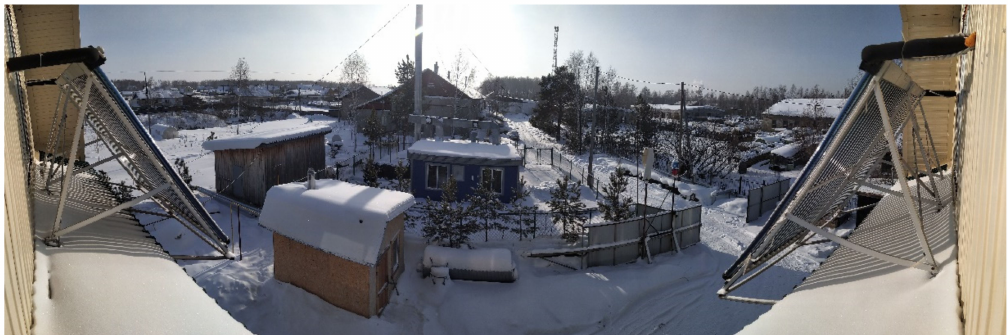
Figure 12. Panoramic photo of evacuated tube collectors with the shadow of the chimney of the gas boiler